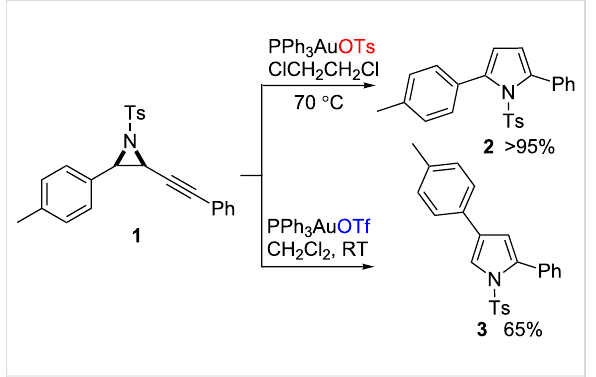
Scheme 1: Gold-catalysed cycloisomerisations of aryl–alkynyl aziri- dine to